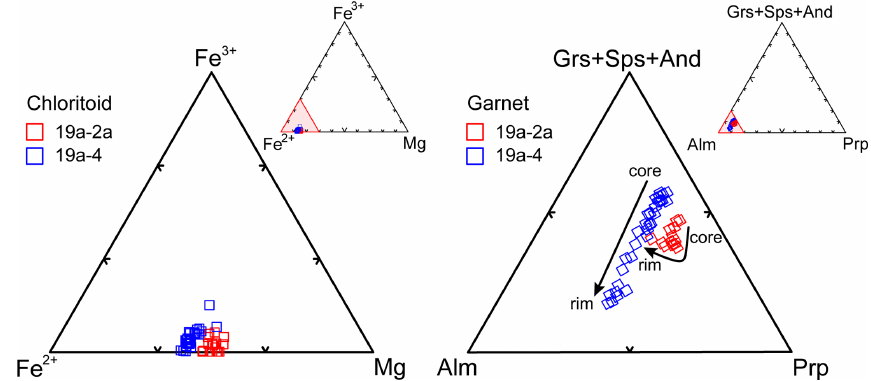
Figure 5. Chemical compositions of chloritoid and garnet from both samples plotted in the Fe 2 + –Mg–Fe 3 + and Alm–Prp–(Grs + Sps + And) diagrams, respectively. The black arrows represent the garnet slight zoning from core to